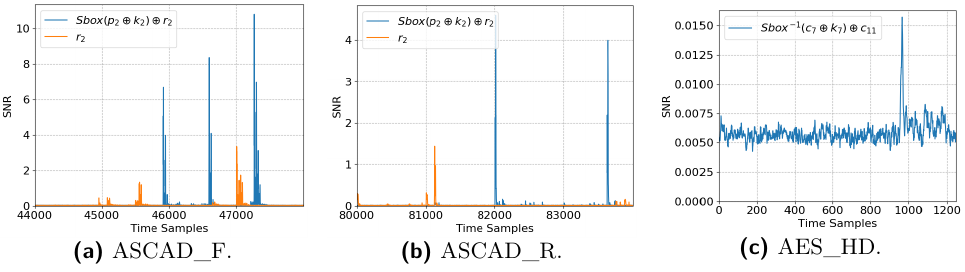
Figure 2: SNR of the three